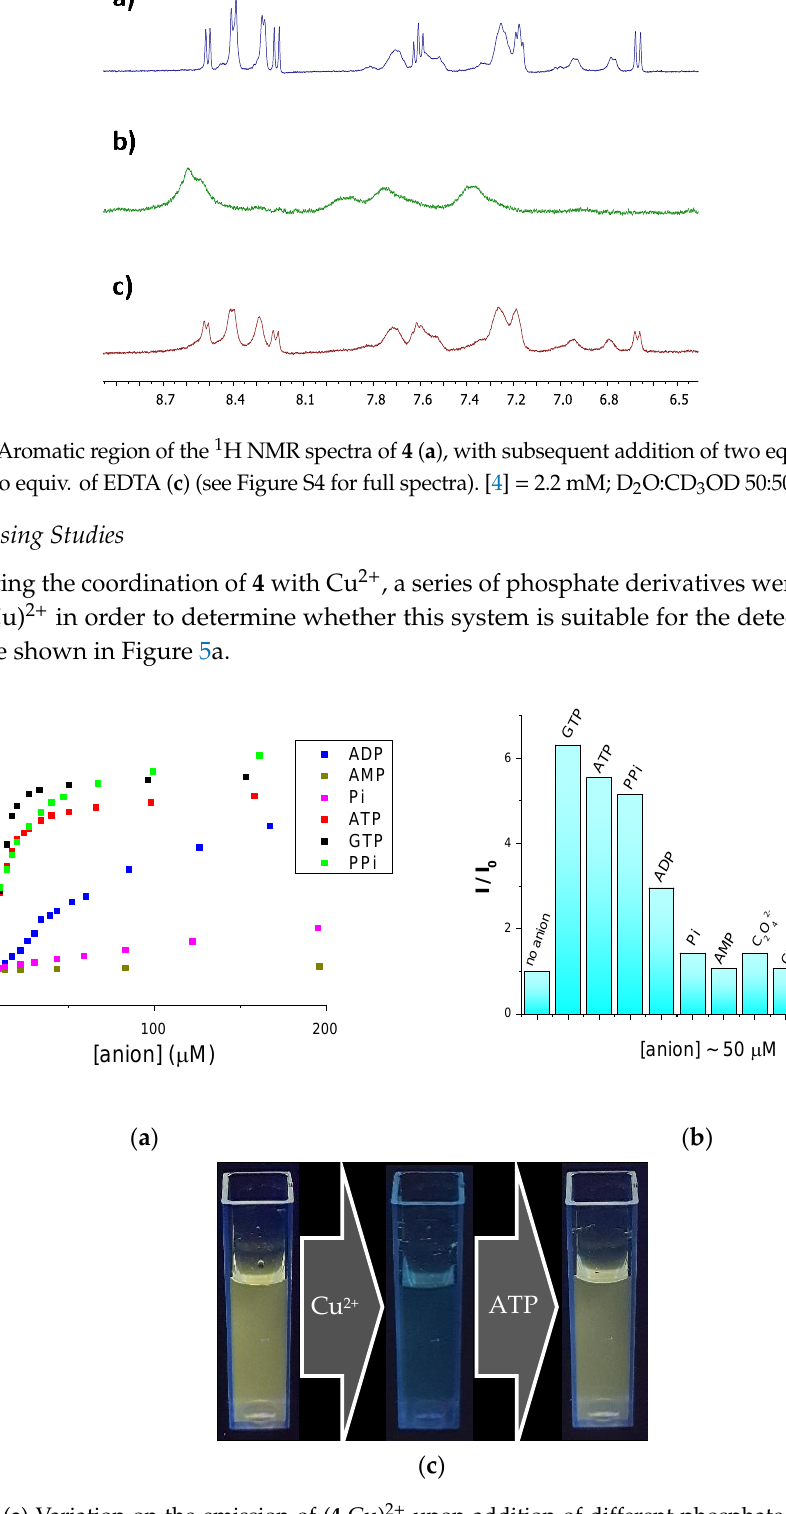
Figure 5. ( a ) Variation on the emission of ( 4 -Cu) 2+ upon addition of different phosphate derivatives (λ exc = 458 nm); ( b ) comparison between ( 4 -Cu) 2+ in the absence (first bar) and in the presence of ~50 µM (10 equivalents) of anion; ( c ) a solution of 4 with sequential addition of Cu 2+ and ATP, under UV light (365 nm). Conditions: [ 4 ] = 5.0 µM; pH 7.0 ± 0.2 buffered with 10 mM HEPES; T = 298 K; λ exc = 458 nm.